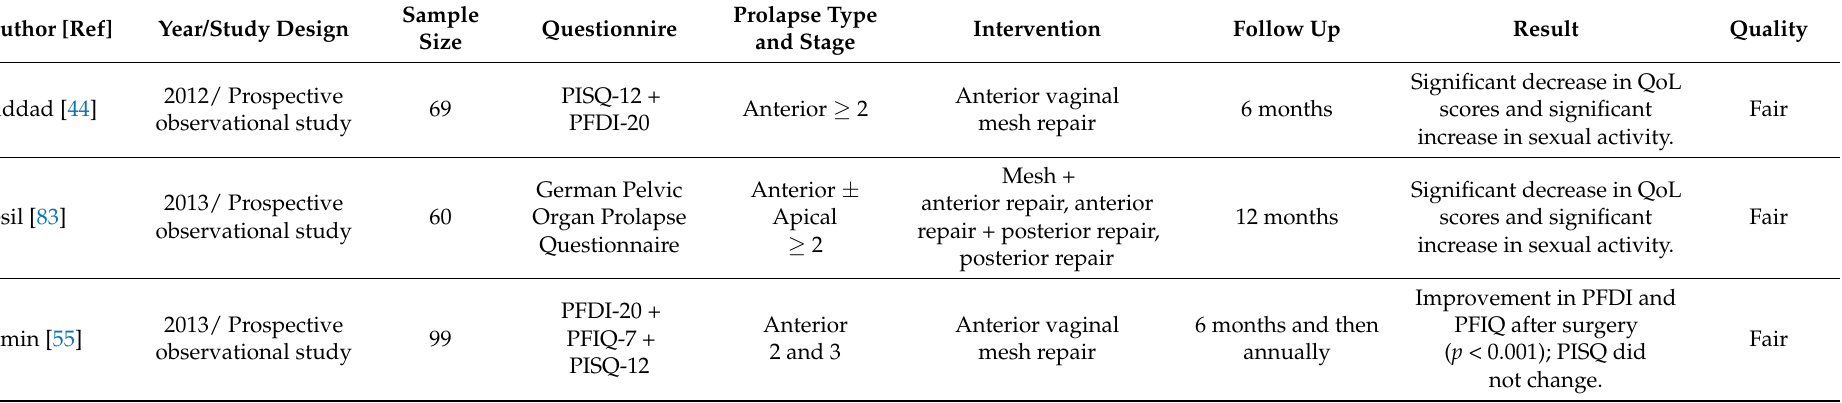
Table 3. The characteristics of the studies on the effectiveness of reconstructive vaginal surgeries with mesh on the quality of life in women with pelvic organ